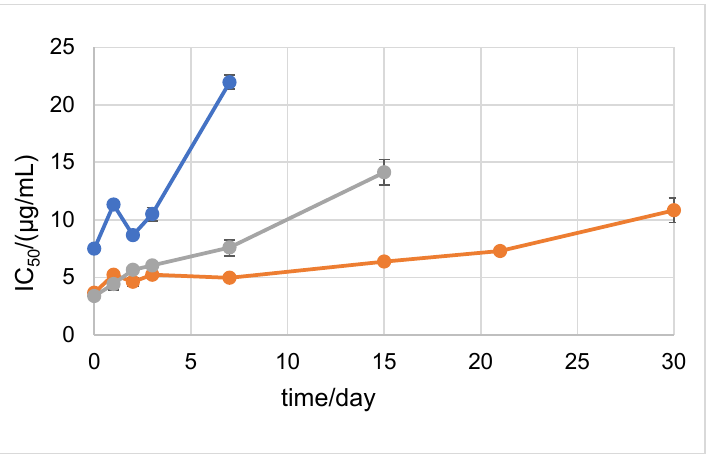
Figure 7. DPPH antioxidant stability of AA, NH 2 AA (D1), and CH 3 NHAA (D2) after 0, 1, 2, 3, 7, 15, 21, and 30 days of incubation at +4 °C in the dark. Results are expressed as µg/mL ± standard devi- ation (SD). D1 derivative is shown in orange, D2 in blue, and AA in gray.